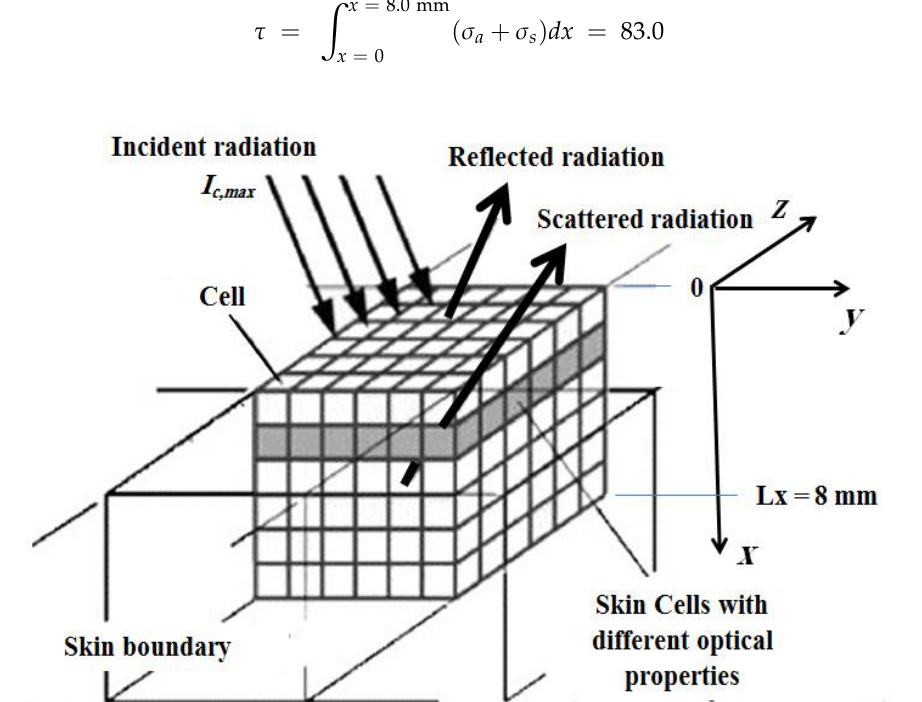
Figure 2. Schematic of the ultrafast laser’s interaction within the skin used in the simulation.